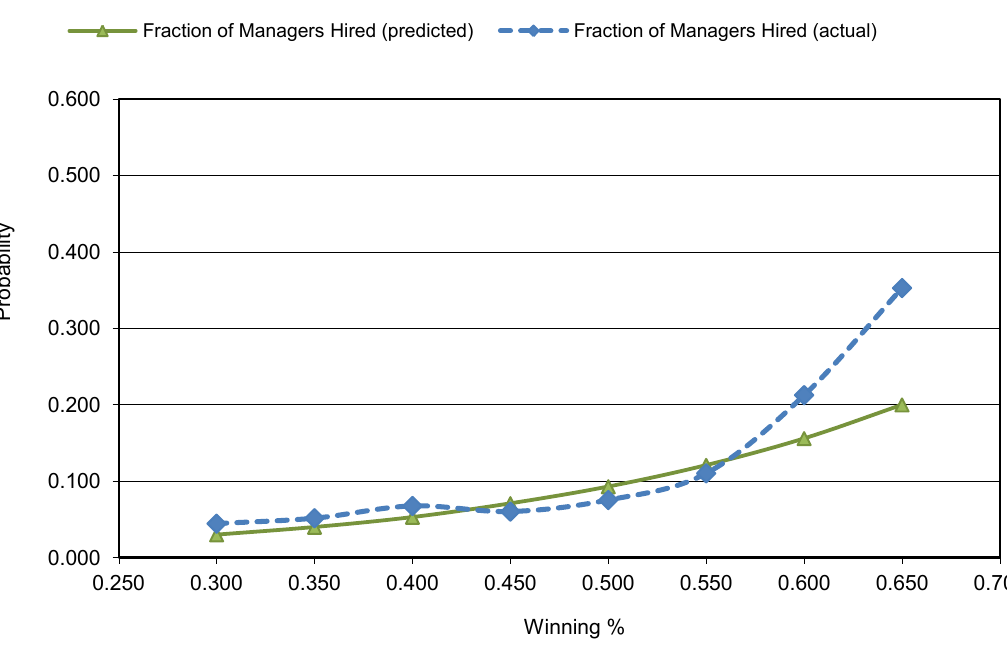
sociological science |